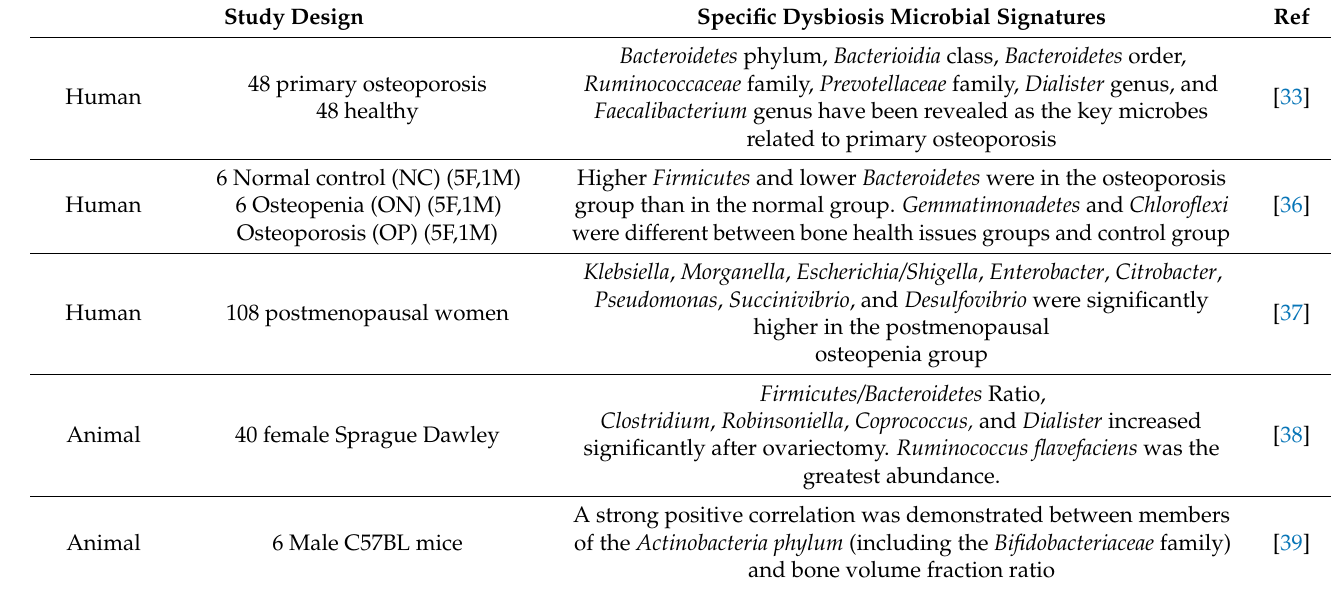
Table 1. Dysbiosis microbial signatures in bone health issues. Study